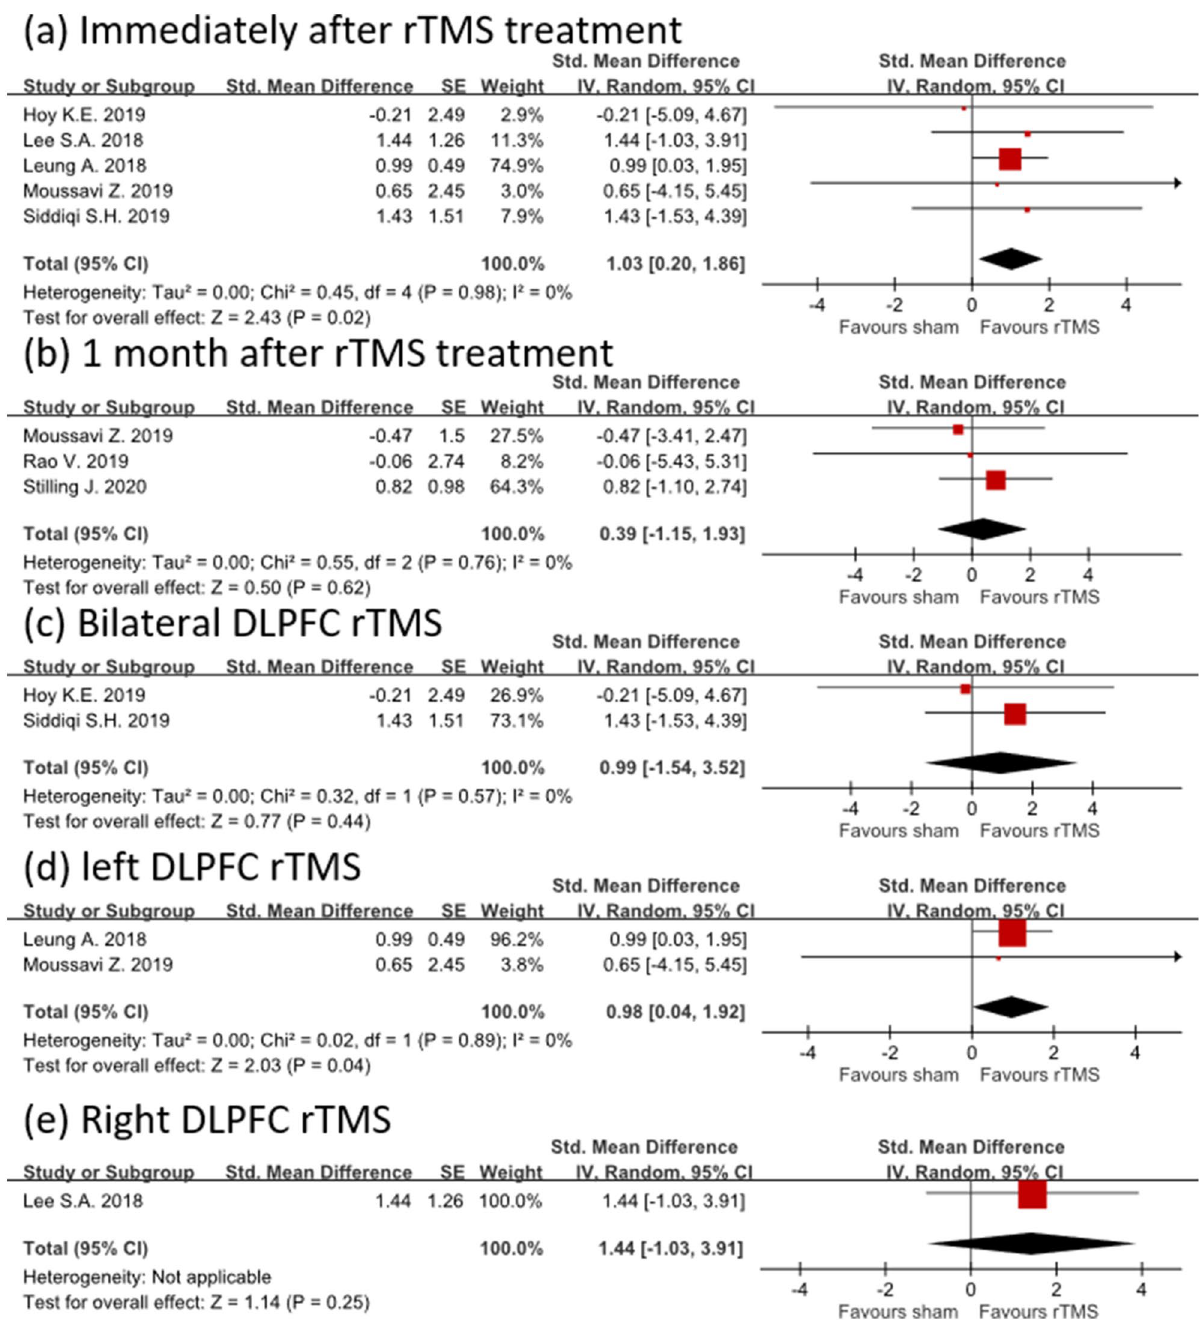
Figure 2. Forest plot showing the efficacy of rTMS versus sham in treating depression. The depression outcome was assessed ( a ) immediately and ( b ) 1 month after rTMS treatment. In the subgroup analysis, the depression outcome was measured immediately after ( c ) bilateral, ( d ) left, and ( e ) right rTMS